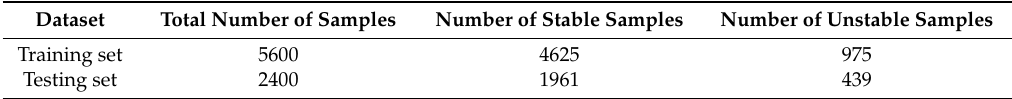
Table 3. Training set and testing set.